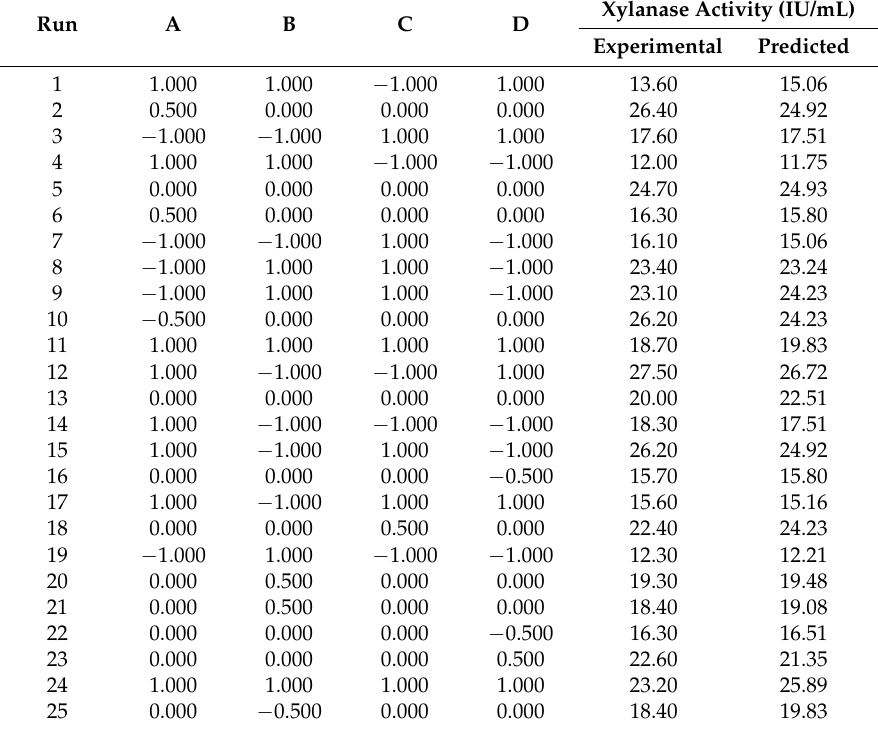
Table 2. Central composite design along with experimental and predicted values of the dependent